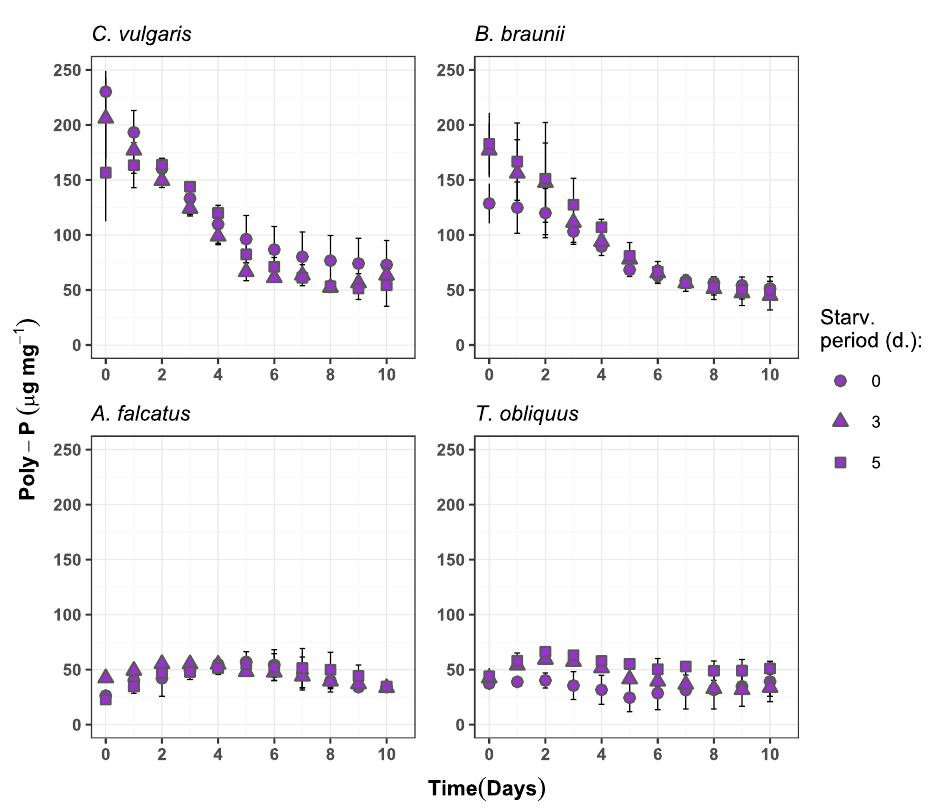
Figure 5. Biomass polyphosphate content change over time in the experiment batches for C. vulgaris, B. braunii, A. falcatus and T. obliquus (means ± SD, n = 3).